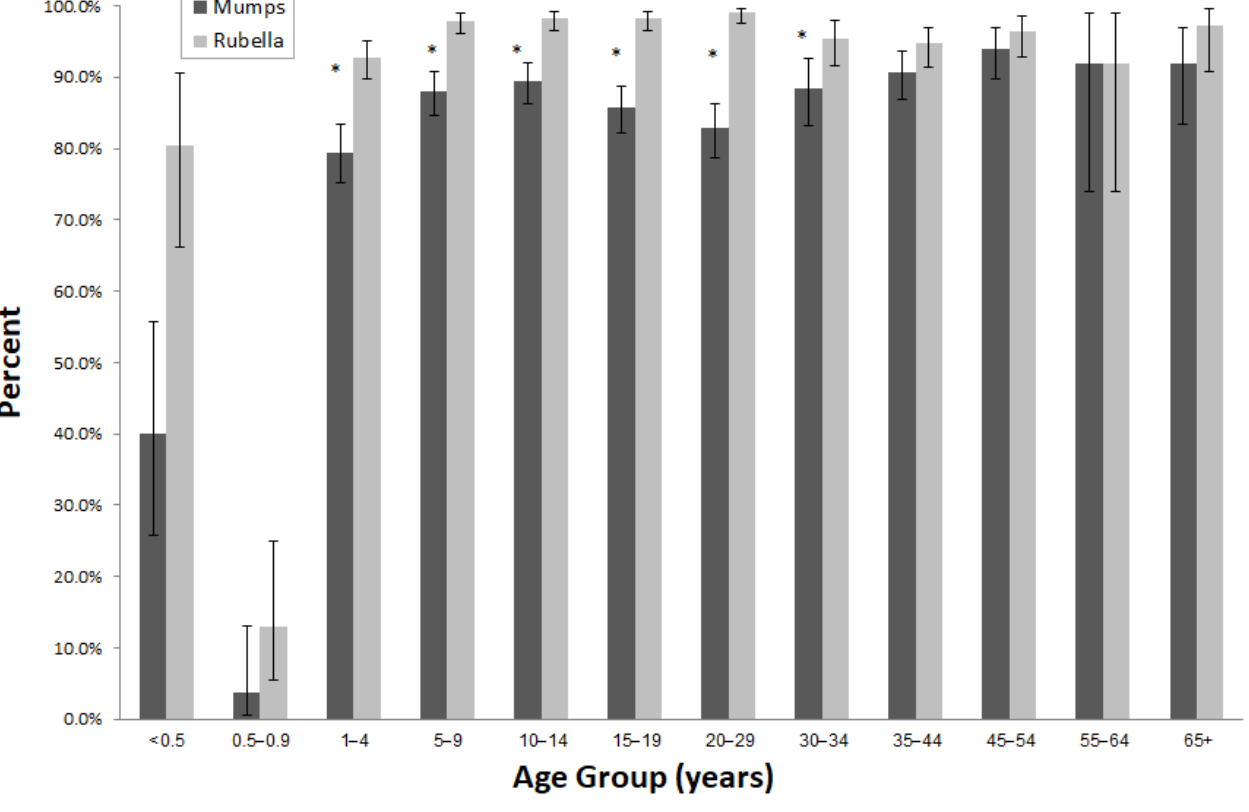
Figure 2. Sero-positivity against mumps and rubella by age group. * p -value < 0.05.